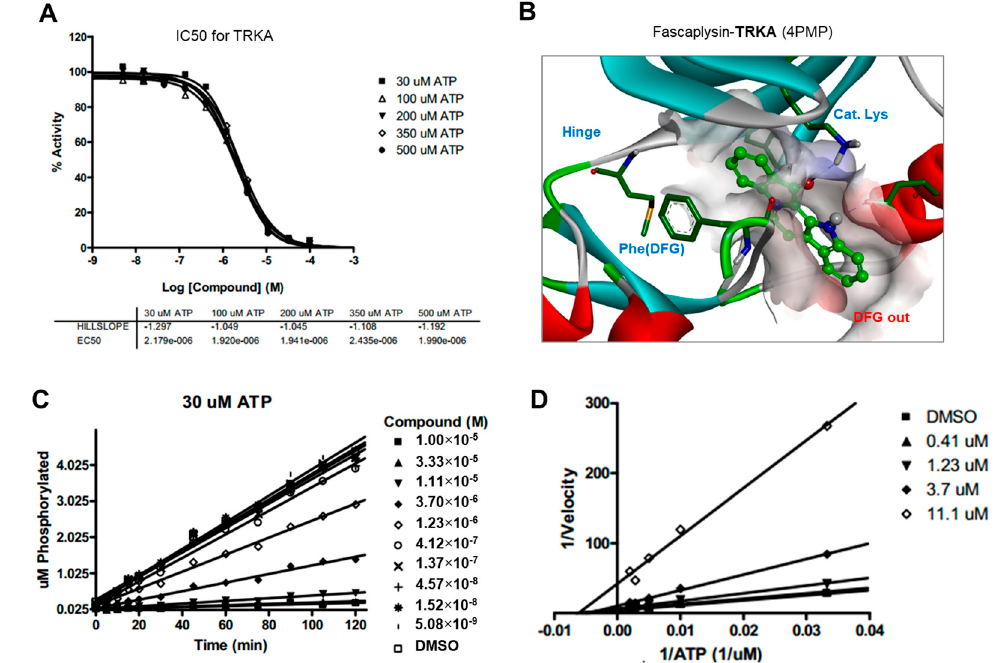
Figure 5. ATP competition studies over TRKA. The inhibition of TRKA by fascaplysin was not time-dependent and was noncompetitive with respect to ATP. ( A ) IC50 curves for TRKA at different ATP concentrations; ( B ) Calculated binding modes of fascaplysin in TRKA; ( C ) Progress curves for TRKA/fascaplysin; ( D ) Lineweaver-Burk plot for TRKA/fascaplysin.